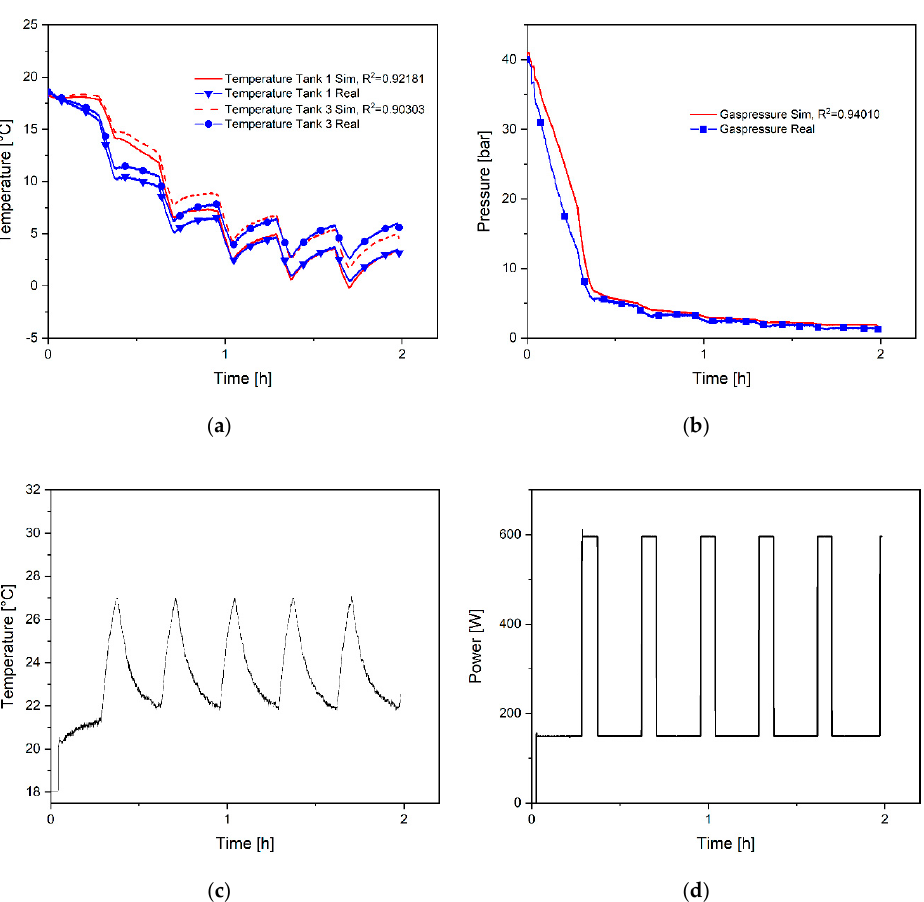
Figure 8. Variable high load conditions: ( a ) Simulated (Sim) and measured (Real) temperature development of tanks 1 and 3, ( b ) Simulated (Sim) and measured (Real) system pressure, ( c ) temperature of air stream from the fuel cell, and ( d ) power of the fuel cell.